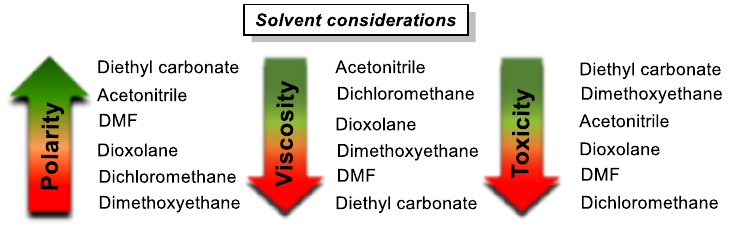
Figure 7. General considerations for choice of solvent for application in all-organic redox-flow batteries. Other parameters that are less limiting (or irrelevant even in some of the highlighted cases) but may be considered include freezing point/boiling point temperatures, and solvent redox potentials. Toxicity was compiled from the LD50 values for rats reported in MSDSs.